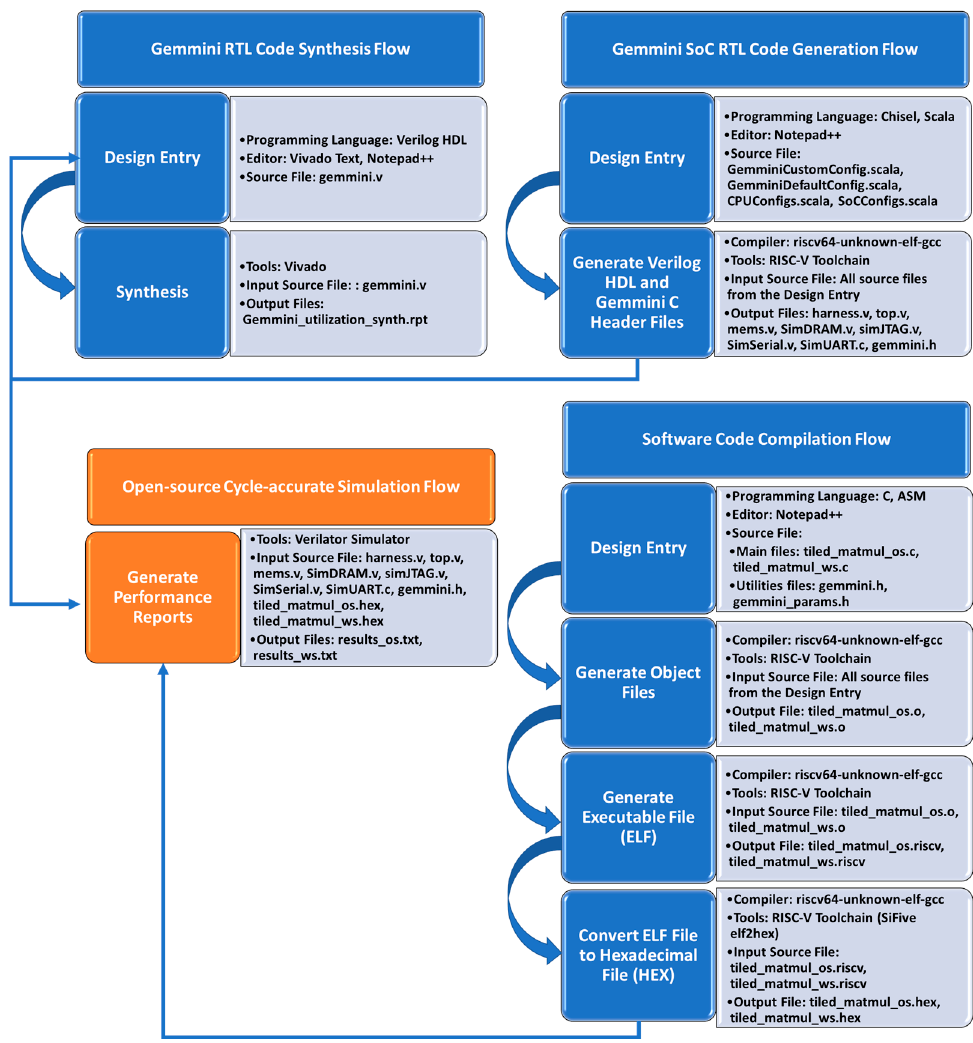
Figure 11. Workflow for exploring Gemmini accelerators.